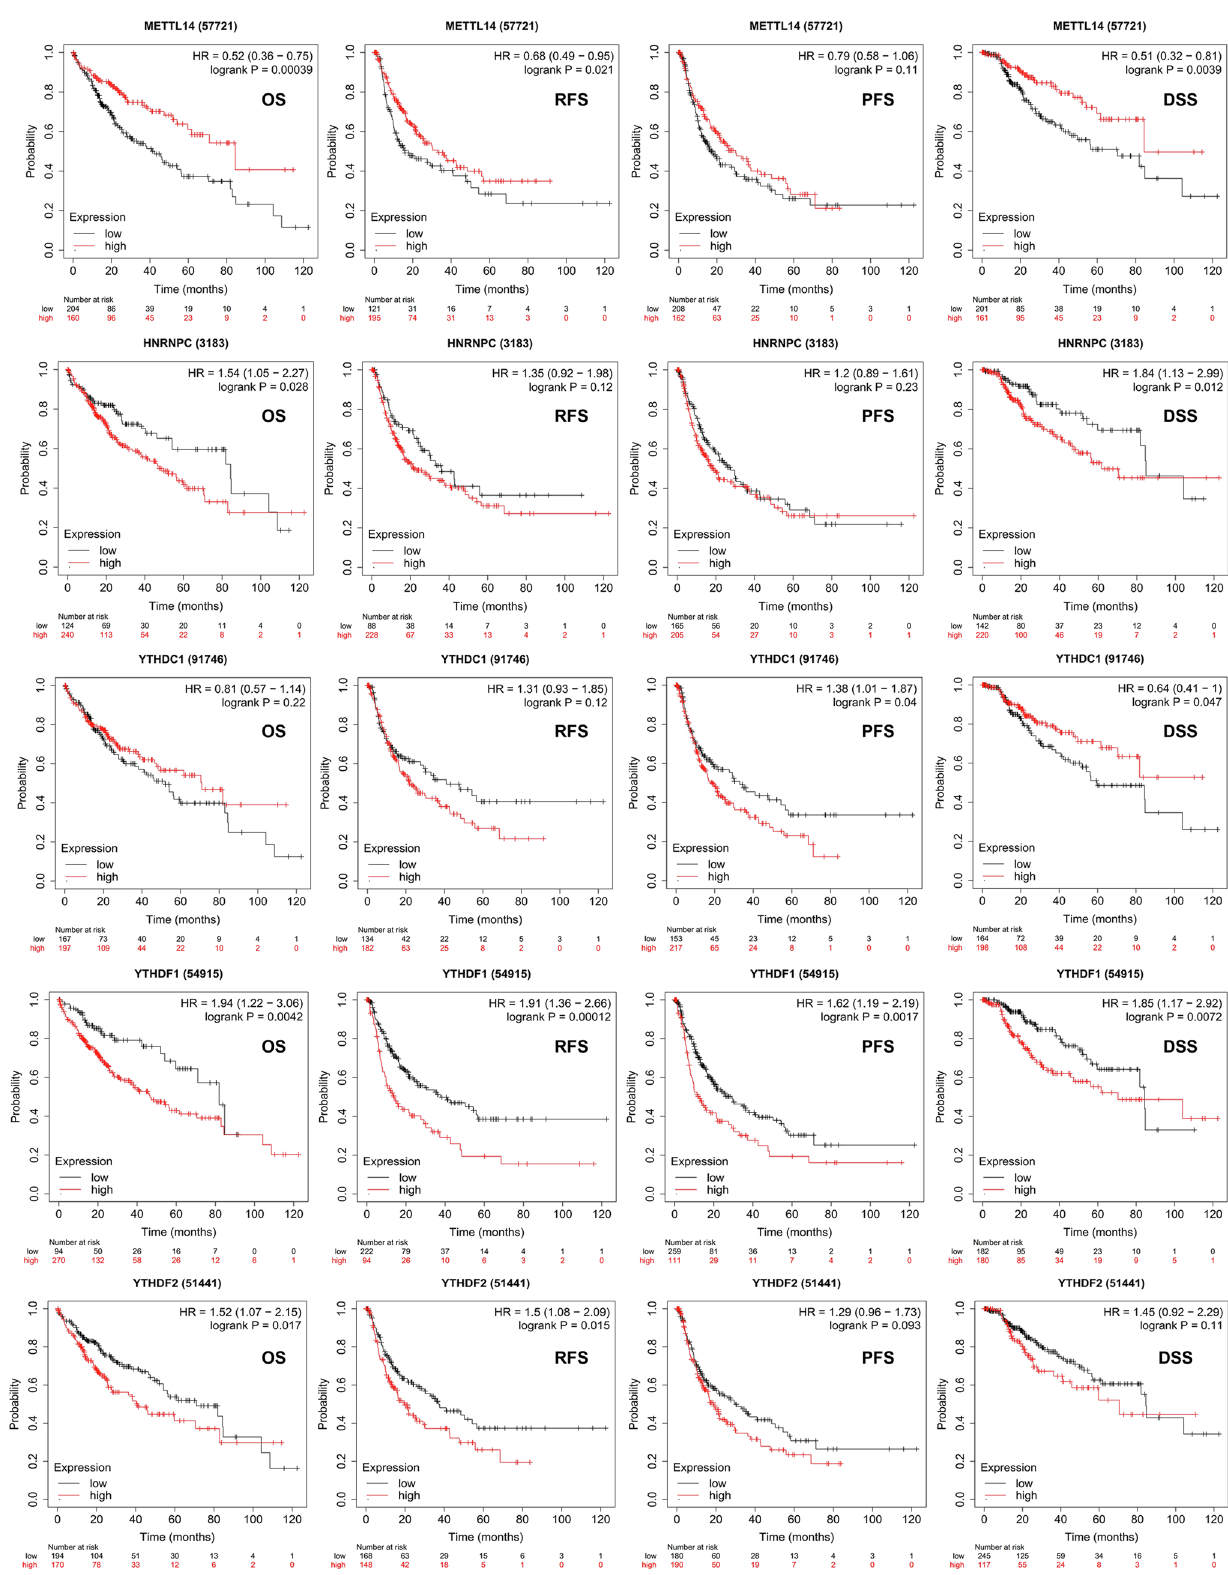
Fig. 5 Prognostic feature of mRNA expression of distinct m6A regulators and PD-L1 in HCC patients (Kaplan–Meier plotter). The OS, RFS, PFS and DSS survival curves comparing patients with high (red) and low (black) m6A regulators and PD-L1 expression in HCC were plotted using the Kaplan–Meier plotter database at the threshold of p-value of <